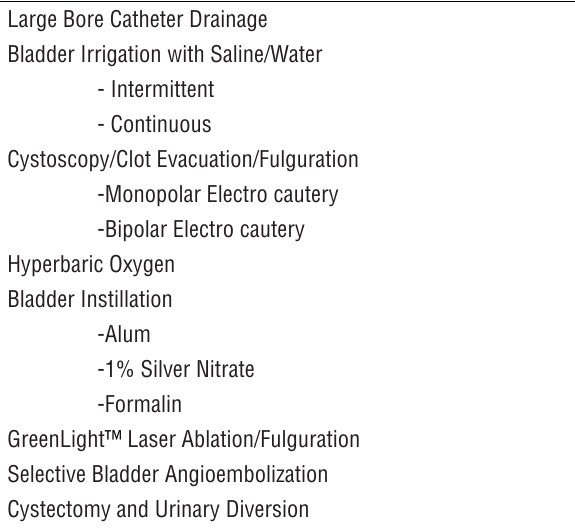
Table 1 - Management options for the treatment of intractable hemorrhagic